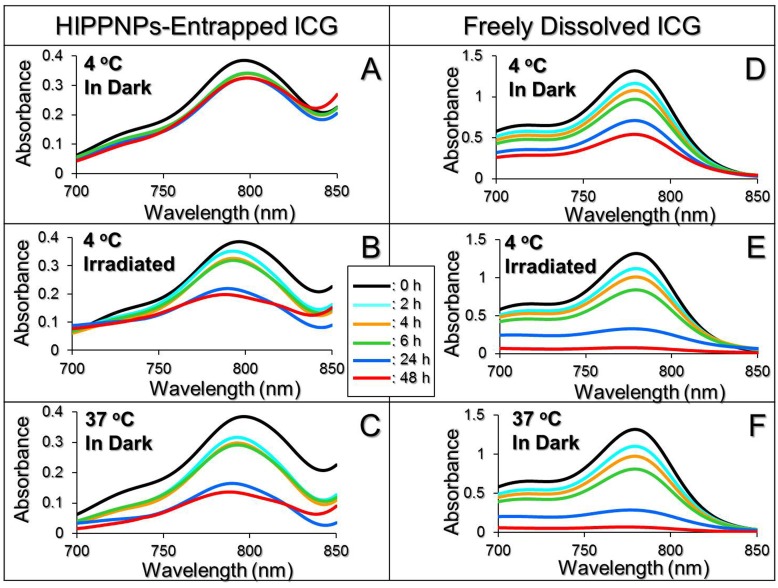
Photo and thermal degradation profiles of HIPPNP-entrapped ICG and freely dissolved ICG in PBS.A—F represent UV-Vis spectra of HIPPNPs (A—C) and freely dissolved ICG in PBS (D—F) treated with 4 or 37°C in the presence and absence of 30 μmol-photons/m2/s light illumination for 48 h as indicated in each figure. The peak at λ = 780 nm in each spectrum denotes the amount of ICG remaining in the HIPPNPs (A—C) or in the PBS (D—F) at 0, 2, 4, 6, 24, and 48 h during photo and/or thermal stimulation.